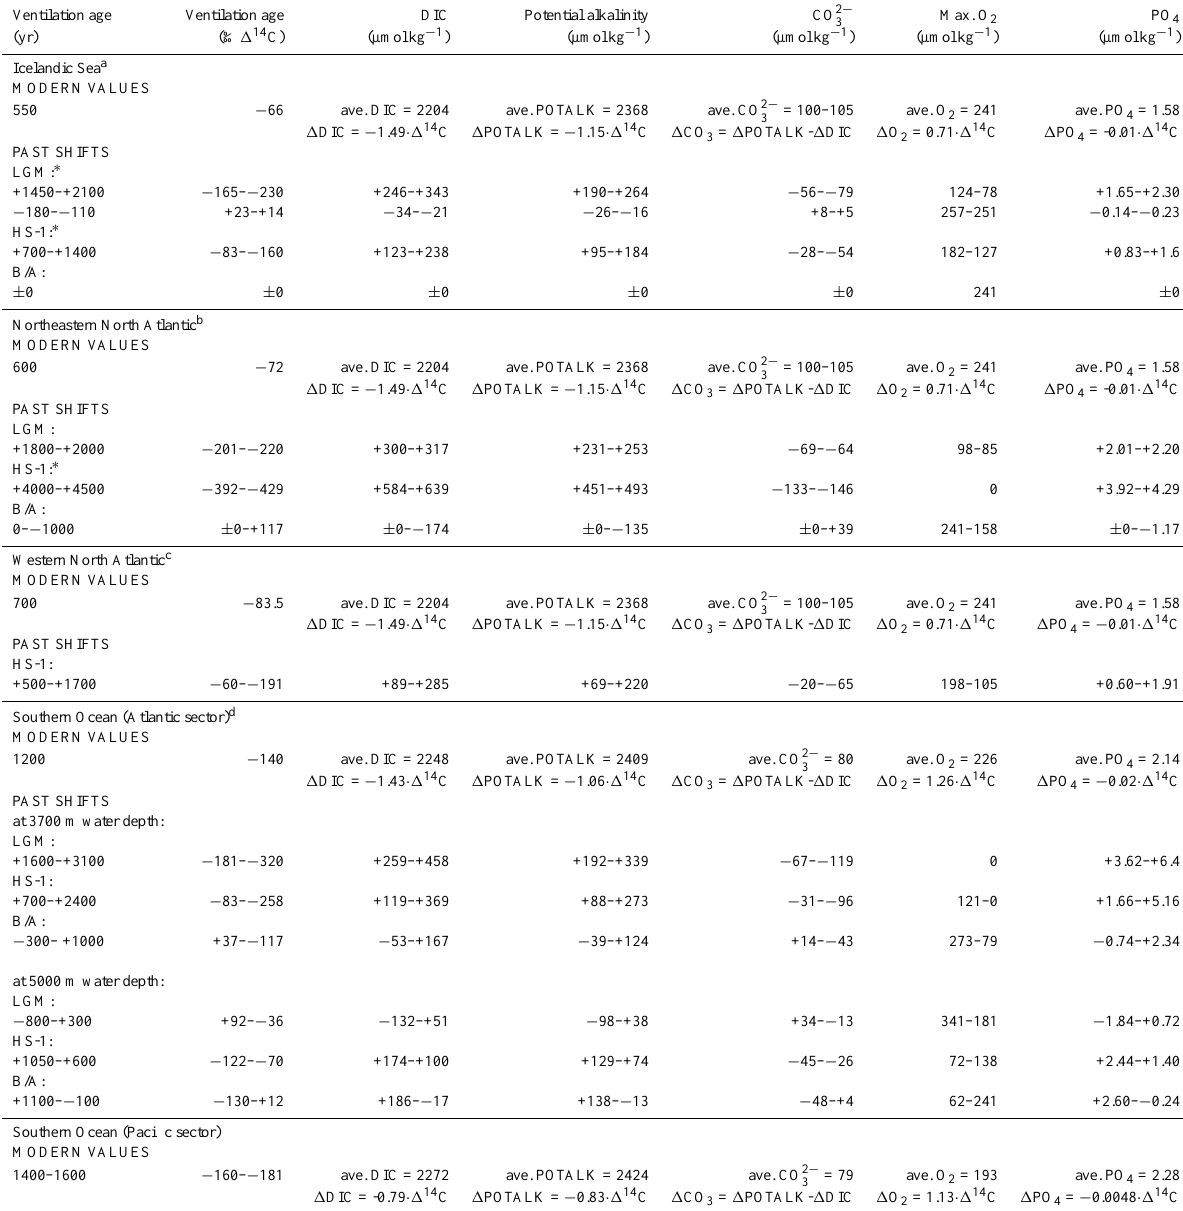
Table 1a. Variability range of shifts in 14 C ventilation age of deep waters vs. today (Matsumoto, 2007) and related shifts in DIC (Fig. 2a), alkalinity (Fig. 4), and CO 2 − µmolkg − 1 ) deduced for the LGM, HS-1, and B/A and various ocean regions below 1500–2000 m w.d. 1 14 C values (‰) for intra-LGM, intra-HS-1, and intra-B/A age differences between atmosphere and deep-water (calculated from apparent benthic ventilation ages; yr) and related DIC, alkalinity, oxygen, and PO 4 estimates (Figs. 2, 4, 6), moreover the difference between these 1 14 C values and their modern correlatives are all calculated for a fraction of “paleo” Modern Carbon (fMC) = 1.0. Using the modern regression slopes characteristic of different regions (based on GLODAP data; Key et al., 2004), we also list average maximum O 2 concentrations and the ratio of PO 4 vs. ventilation age. Records PS2644 and RAPiD-10-1P are incorporated from above 1500 m w.d., as these sites match immediate source regions of modern NADW to the north and south of Iceland, except for HS-1, where they record a northward flow of intermediate waters (Fig. 3b). From less than 2000 m w.d. we incorporate records of Site 17940 from 1727 m in the South China Sea, since it is bathed in deep waters entrained from Upper Pacific Deepwater, and Site MD01-2378 from 1787 m depth in the Eastern Indian Ocean, which is bathed in Upper Indian Ocean Deepwater. Because of too low benthic specimen numbers in Core PS2644, the B/A age for the Icelandic Sea is not based on direct dating but on analogies to today, deduced from high local benthic δ 13 C values of 1.1–1.4‰ (Voelker, 1999), thus earmarked by a question mark in Fig.